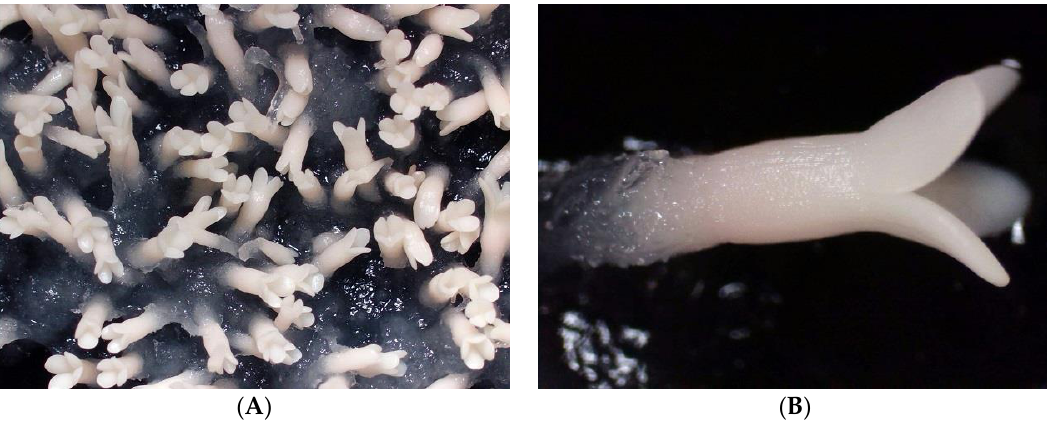
Figure 2. Somatic embryo maturation in sugi (Japanese cedar, C. japonica ). ( A ) Maturation of somatic embryos 8 weeks after the transfer of ECs to maturation medium; ( B ) a close-up of developed cotyledonary embryo. Bars: 5 mm ( A ), 1 mm ( B ).